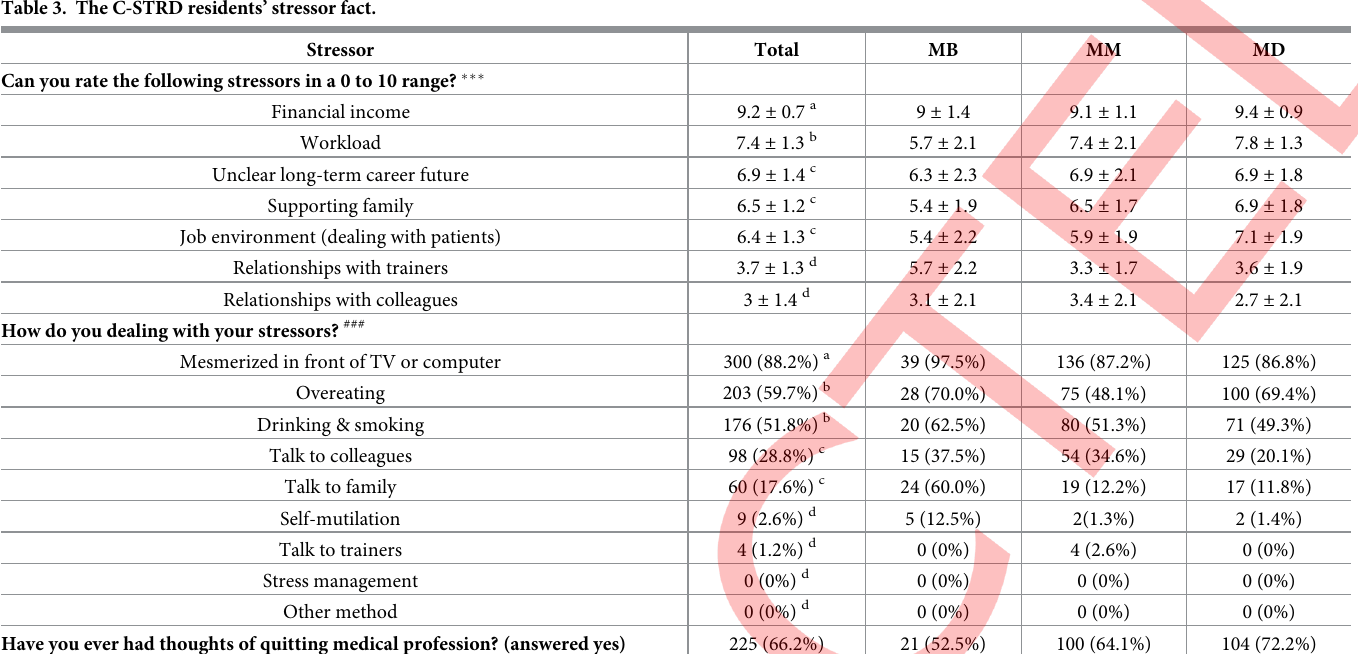
Table 3. The C-STRD residents’ stressor